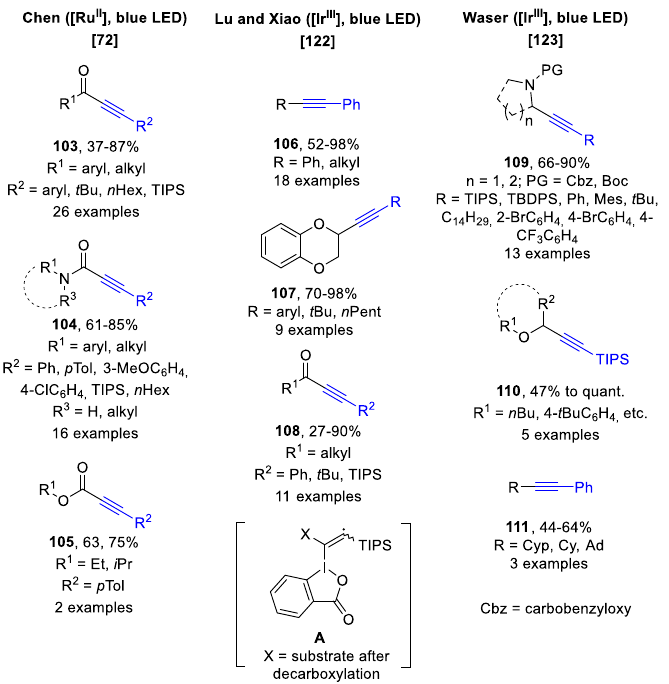
Figure 2. Products 103 – 111 and intermediate A of Ru(II) or Ir(III) photoredox catalyzed alkynylation with the use of EBXs [72,122,123].